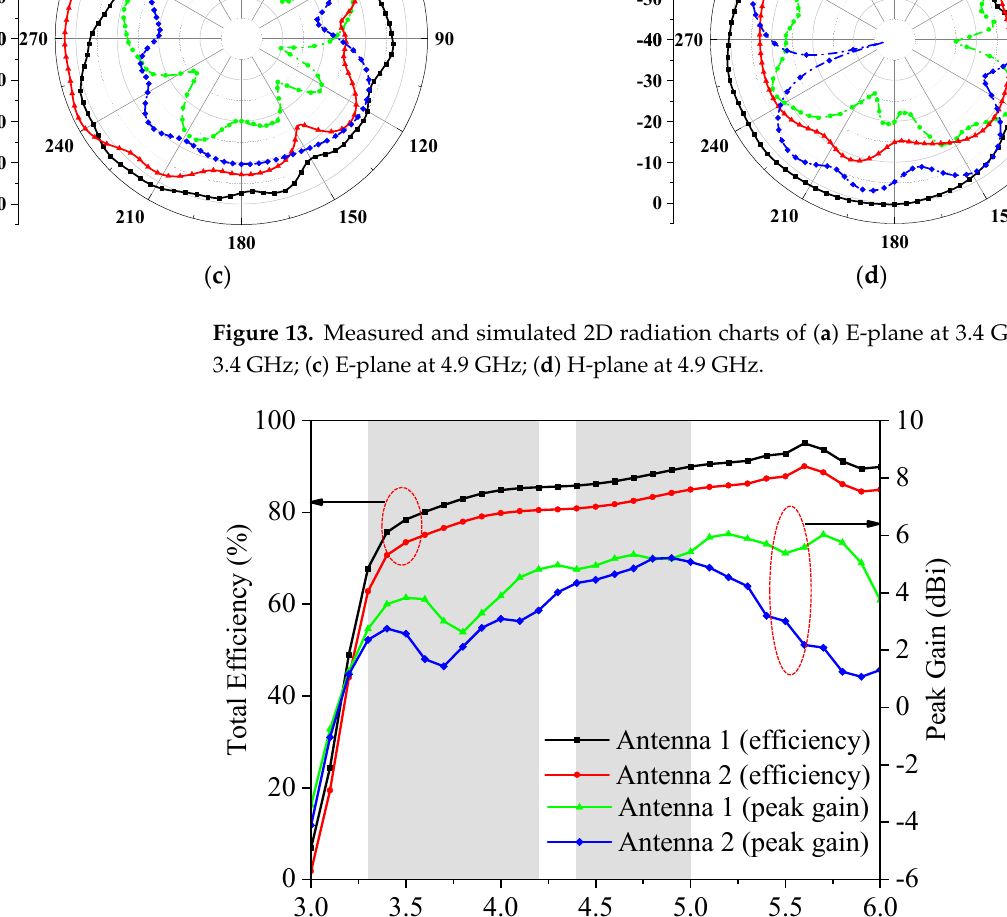
Figure 13. Measured and simulated 2D radiation charts of ( a ) E-plane at 3.4 GHz; ( b ) H-plane at 3.4 GHz; ( c ) E-plane at 4.9 GHz; ( d ) H-plane at 4.9 GHz.